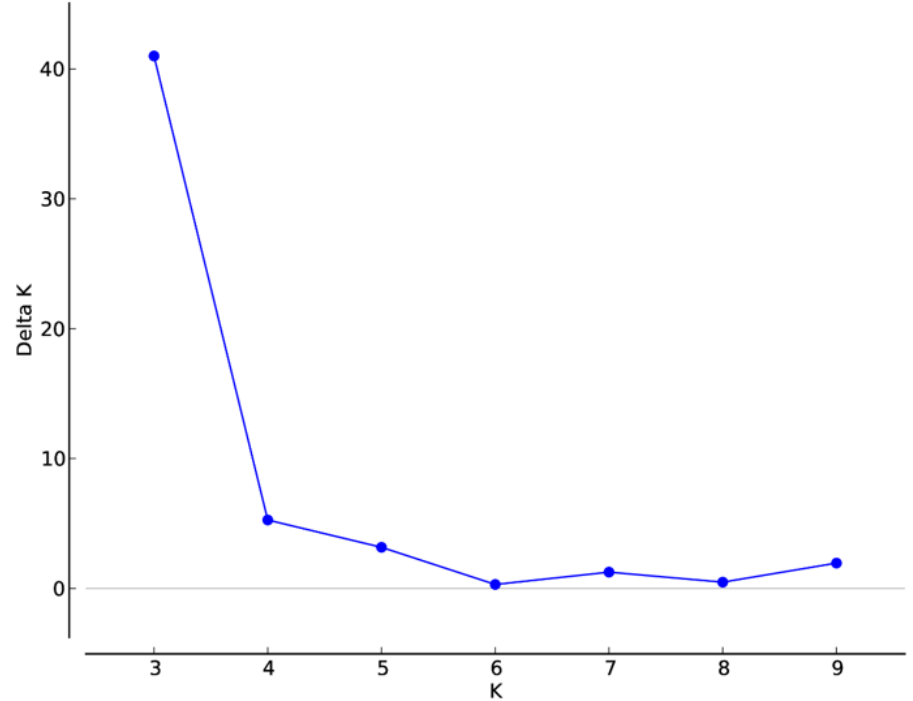
Figure 4. Estimation of the number of populations using LnP(D)-derived Delta k from 2 to 10 using SSR data.